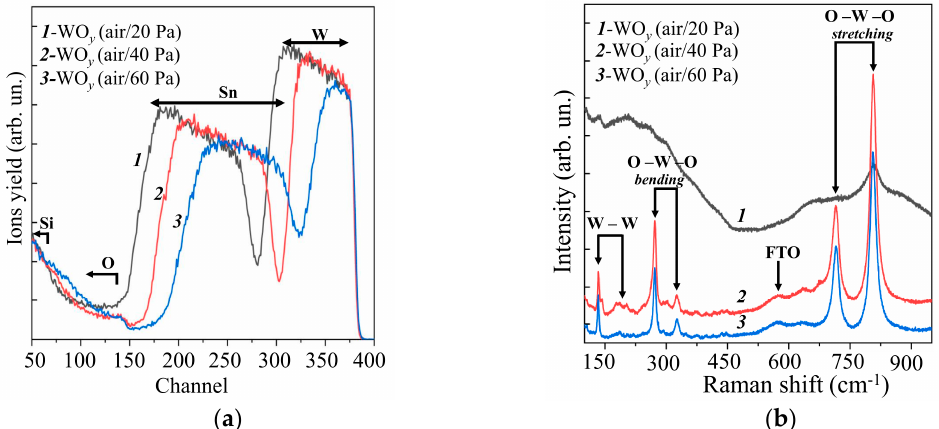
Figure 1. Experimental ( a ) RBS and ( b ) Raman spectra for the WO y films obtained on an FTO substrate by RPLD at different pressures of dry air.